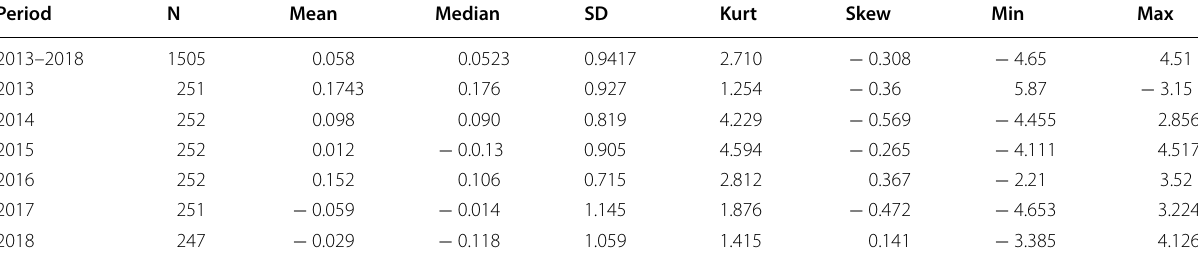
Table 1 Summary statistics for “KSE-100 Index” returns